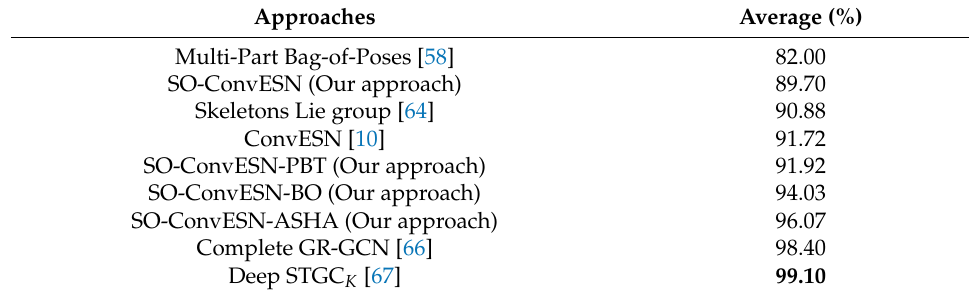
Table 6. Recognition accuracy on 10-fold cross-validation Florence3D-Action